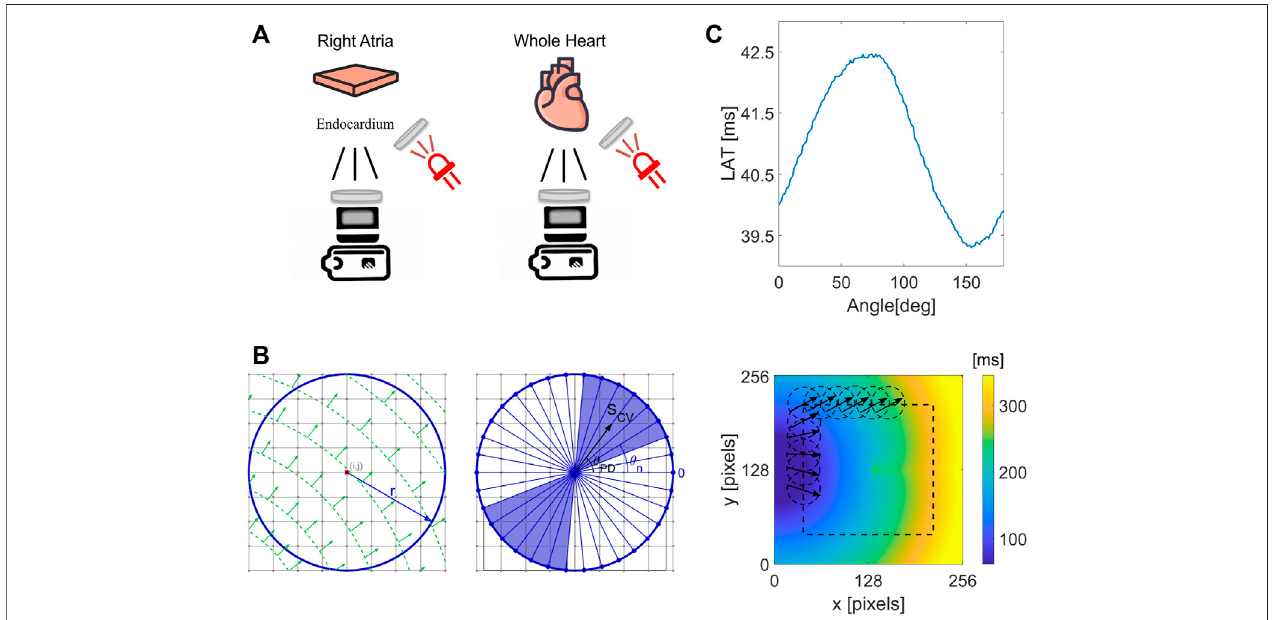
FIGURE 1 | Illustration of the experimental setup and the CM method application to obtain local CV and CV maps. (A) For isolated rat atria, RFA was performed in stepsofincreasingablation durationof0.5,1,1.5,2,2.5,3,and 4 s,with2 minpausebetweenthesteps.Theablation wasperformedontheepicardialsidewithoptical mapping measurement on the endocardial side. The ablation was performed on the ventricular tissue for the whole guinea pig heart and human heart preparations. Collimated and bandpass- fi ltered LED light was used to excite the V m dye. Emanating fl uorescent light was passed through the long-pass fi lter in front of the EMCCD camera sensor. (B) Illustration ofthe circle method, evaluating LATs differencesat the points along acircle ofradiusr, centered at a grid point (i,j). Left, example ofawavepropagatingat45 ° .Right,asetoftestCVvalues, S ( θ n ),whichisevaluatedbytakingthedifferenceinLATsalongdiameters(bluelines)atdifferentangles θ n .The circlemethodevaluatestheresultingconductionvelocitybyperformingageometricallyweightedaverageof S ( θ n )overanangularrangearound θ PD (blueshadedregion). (C) Top, an example of a set of LAT differences for different chords, with a clear maximum along the chord normal to the propagating wavefront along vector S CV as in (B) . Bottom, application of the CM method at every pixel in the LAT map inside the dashed rectangular region, obtaining local CV